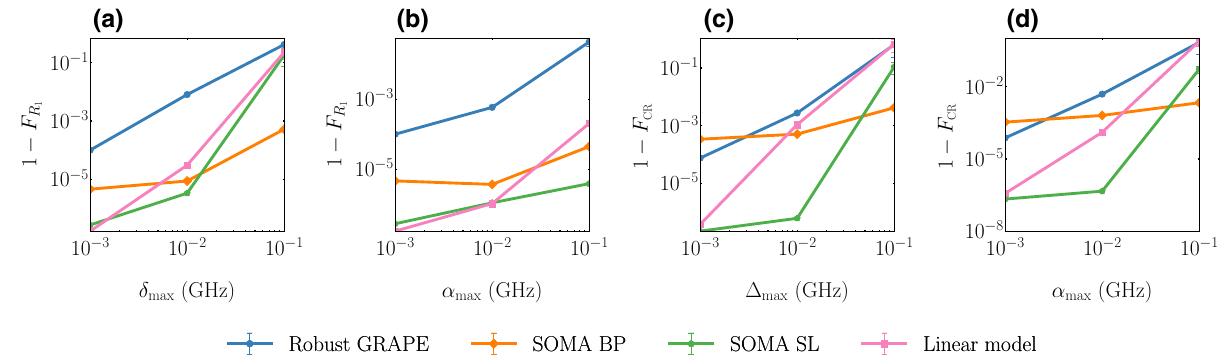
FIG. 7. A comparison of four different generalized optimization methods as a function of the parameter space size, when only one parameter range is varied, while all the others are kept constant at 10 − 3 GHz: (a),(b) the results for the single-qubit gate R 1 (θ) ; (c),(d) the results for the CR (θ) gate. Both axes are on a logarithmic scale and represent the average infidelity over 1000 test samples. The values δ max , α max , and (cid:7) max on the horizontal axes represent the maximum range of the corresponding problem parameter, δ , α , and (cid:7) . The maximum range defines the parameter space over which the QOC problems are sampled. We observe how the neural network trained with the supervised algorithm outputs pulses with higher average fidelity than the other methods but it fails nonetheless when the detuning variation in the two different systems is increased up to the order of 100 MHz. In this case, the model trained with SOMA BP, however, still outputs high-fidelity